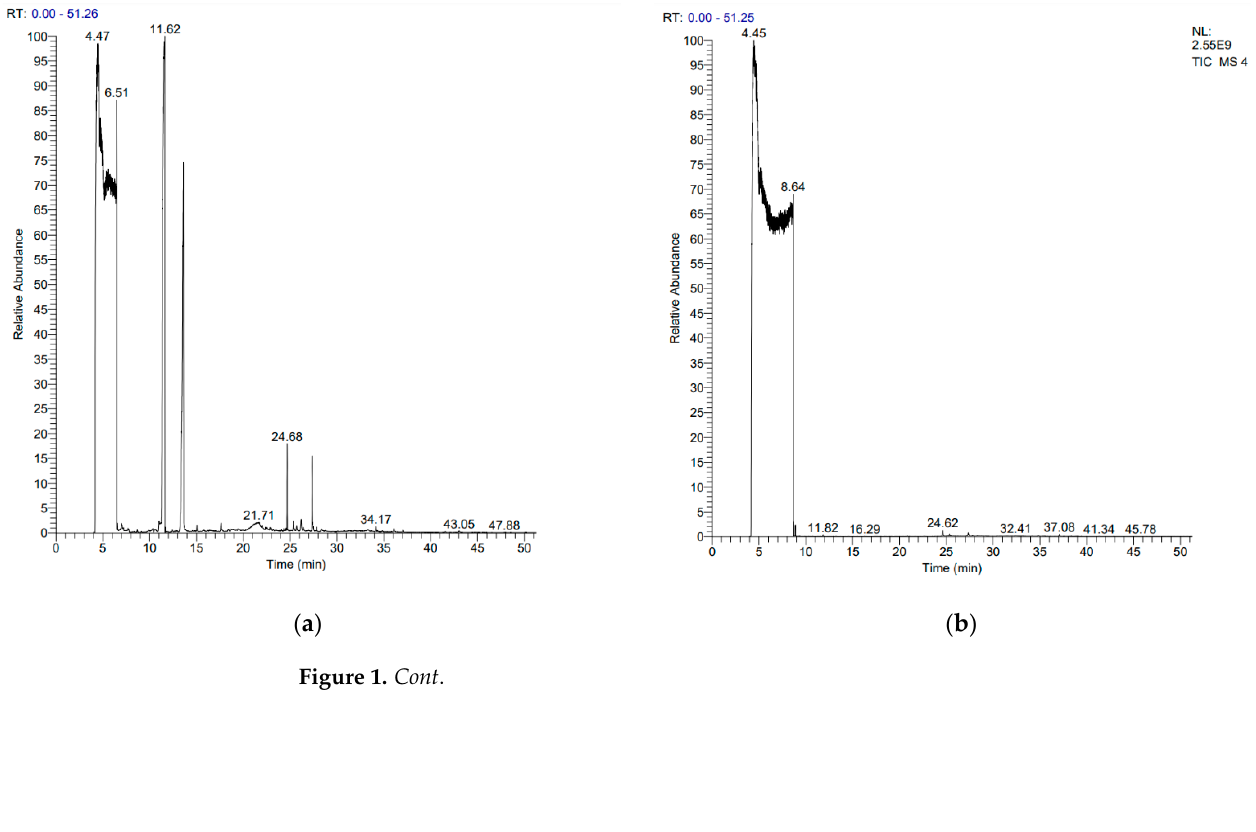
( c ) Figure 1. GC–MS chromatograms of FADE ( a ), FZDE ( b ), and FHDE ( c ) extracts. Various levels of polyphenols and flavanols such as nicotinic acid, p -hydroxybenzoic acid, hexadecanoic acid, protocatechuic acid, pentanoic acid, vanillic acid, gallic acid, O - coumaric acid, and caffeic acid have been identified in palm date extracts [14]. Primary and secondary metabolite profiles of 21 date varieties from Egypt were analyzed by Farag et al. [15], who reported that caffeic acid conjugates ( O -caffeoyl shikimic acid), flavonoids (quercetin and luteolin glycosides), sphingolipids, fatty acids, and flavonoids were detected as the most abundant classes amongst all the examined P. dactylifera fruit samples.